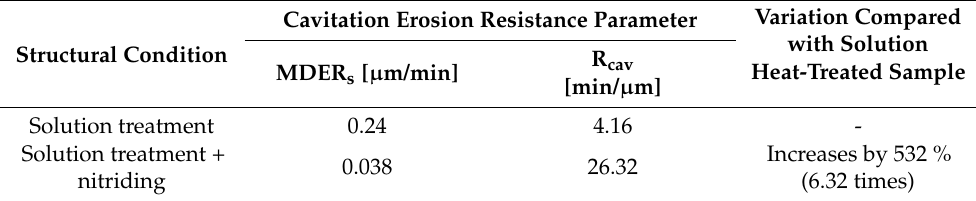
Table 5. The effect of nitriding on MDER s and R cav values.